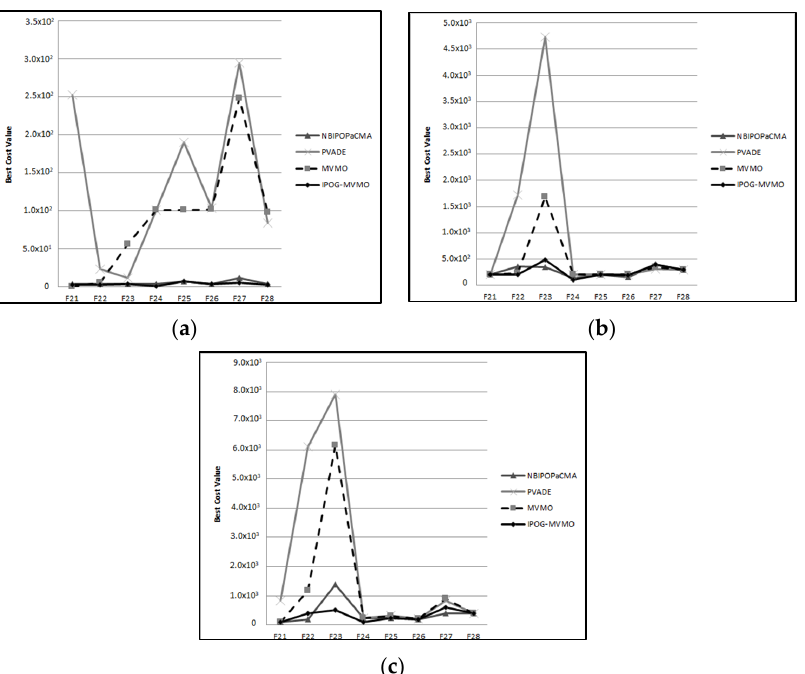
Figure 3. Comparison of the best cost value for F21–F28 at ( a ) 10 dimensions, ( b ) 30 dimensions, and ( c ) 50 dimensions.